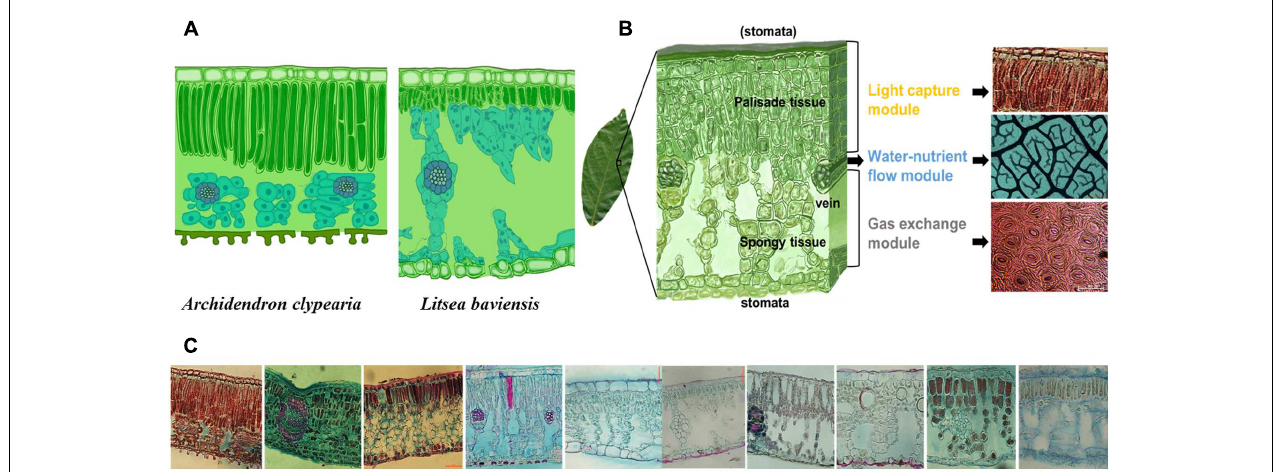
FIGURE 1 | Illustration of the concept of modularity of leaf design. Different species can have different internal leaf structures such that the key leaf trait, leaf dry mass per unit area (LMA) alone may not be informative enough for describing the diversity of leaf designs as exemplified by a comparison of two species with similar LMA (77.3 g m − 2 for Archidendron clypearia and 68.9 g m − 2 for Litsea baviensis ) (A) . A frequently observed mode for the combination of three key sub-leaf modules: from top to bottom, a leaf can be divided into a light capture module, a water-nutrient flow module and a gas exchange module (B) . Demonstration of the vast diversity of leaf internal structures. Such diverse leaf designs can be seen as the result of different adjustments to the frequently-observed mode (C)